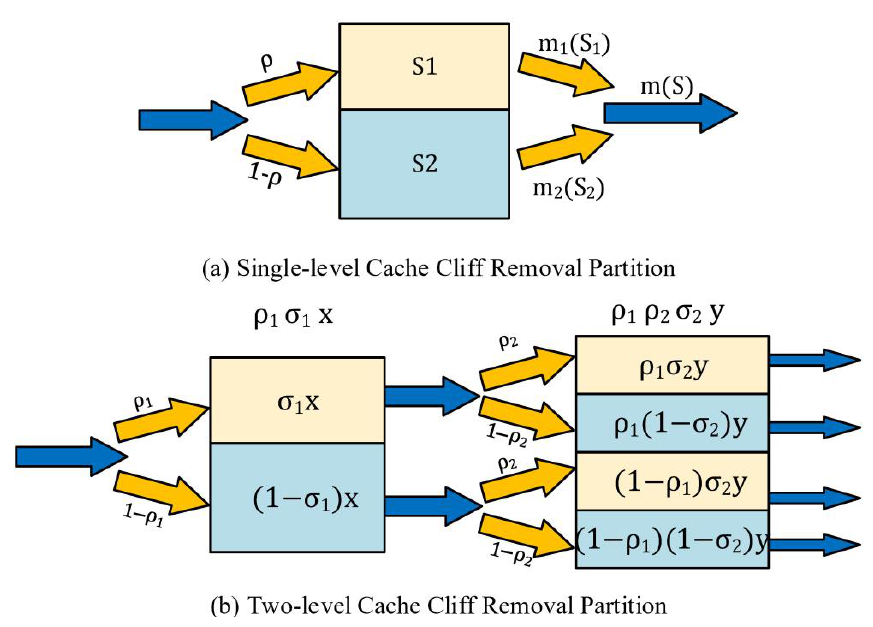
Figure 2. Partition Scheme to Eliminate the Cache Performance Cliff